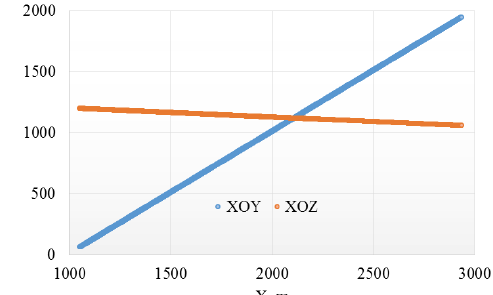
Figure 2. Projection of spatial line on planes XOY and XOZ